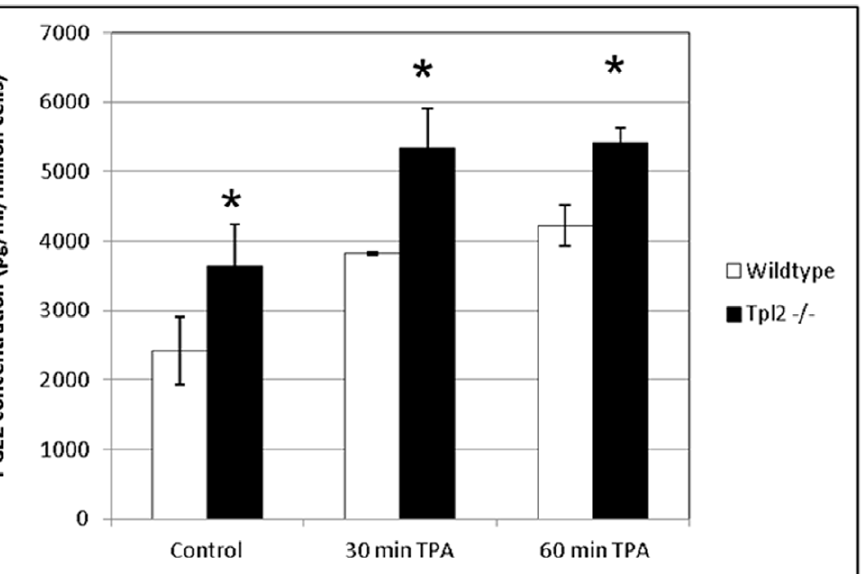
Figure 2. PGE 2 production is higher in keratinocytes from Tpl2 2 / 2 mice. Wildtype or Tpl2 2 / 2 keratinocytes received vehicle (DMSO) or TPA (10 ng/ml). Supernatants were collected after 30 or 60 minutes of TPA treatment. PGE 2 concentration was determined using a PGE 2 immunoassay kit. Significant differences were found between genotypes at all time points (p , 0.003).